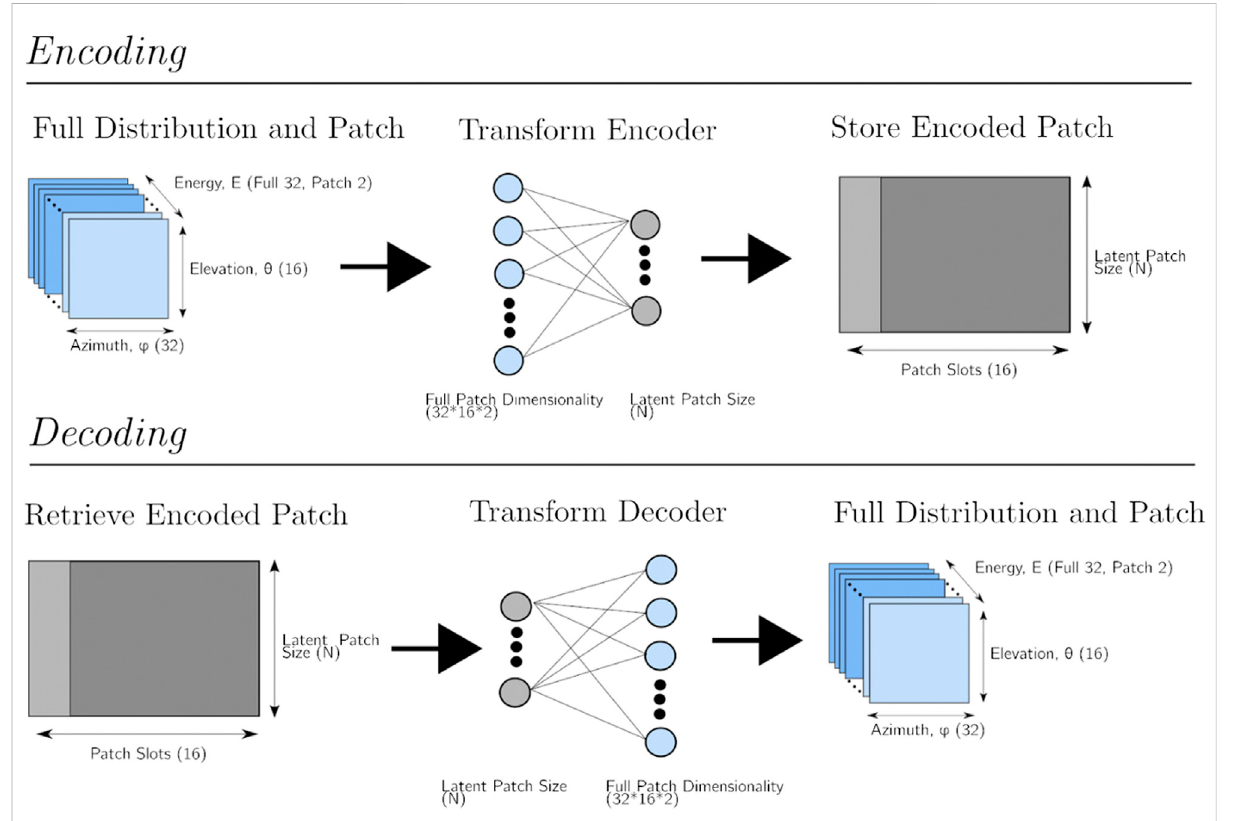
FIGURE 1 The neural network encoding and decoding steps of the dimensionality reduction method. A normalization to guarantee the mean number of counts is preserved is not shown here. In the encoding step, a patch is retrieved from the full counts distribution structure, fl attened, and processed through the transform encoder network. The encoded form of this patch is stored as a column in a matrix, where the number of columns is the number of patches. For the decoding step, an encoded column is retrieved from the table, passed through the decoder, and placed back in its original location in the full counts